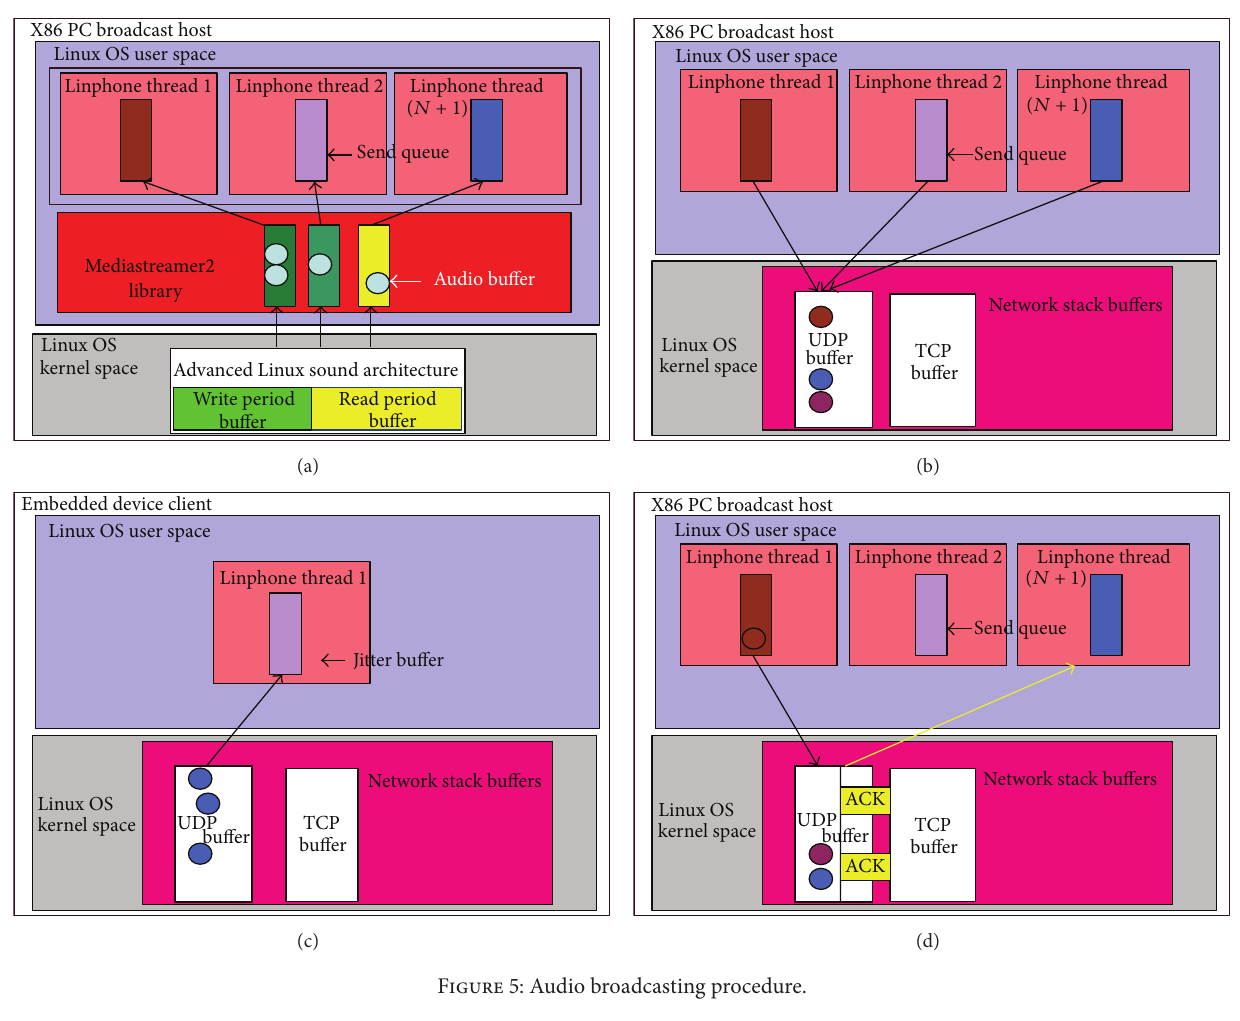
Figure 5: Audio broadcasting procedure.